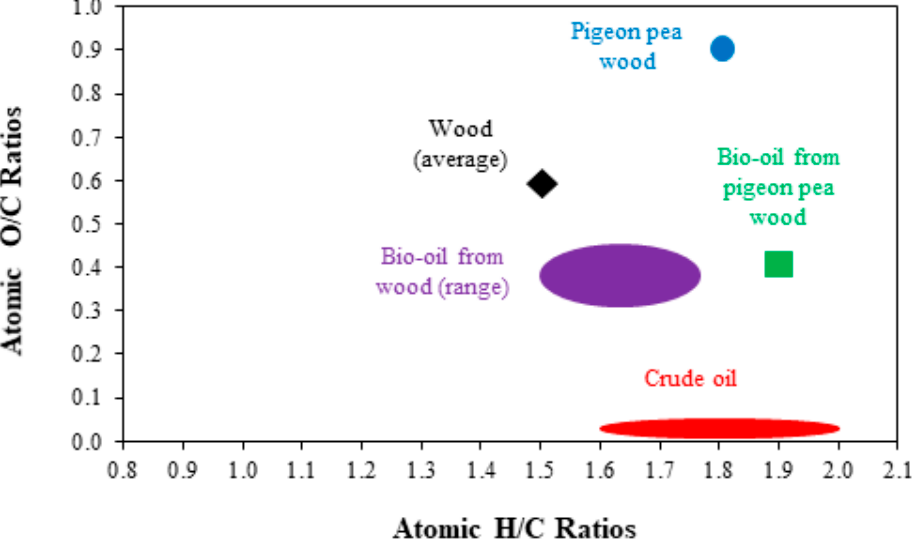
Figure 5. van Krevelen diagram (dry basis) for pigeon pea wood (blue circle) and its product bio-oil (green square) obtained after pyrolysis reaction at optimized conditions, in comparison with woody biomass feeds and products [35].